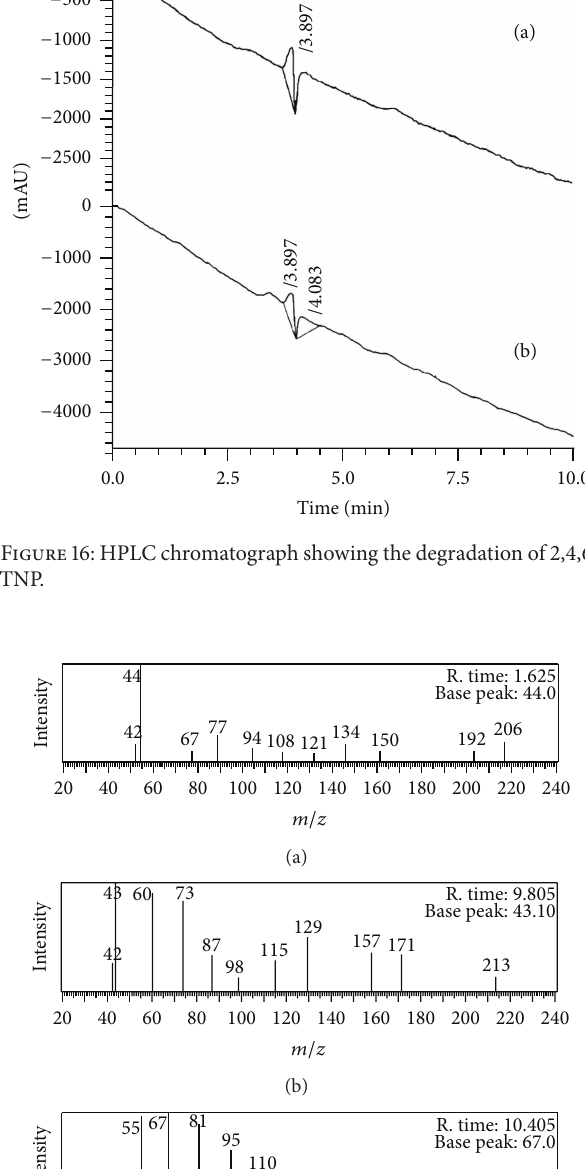
R. time: 10.405 Base peak: 67.0